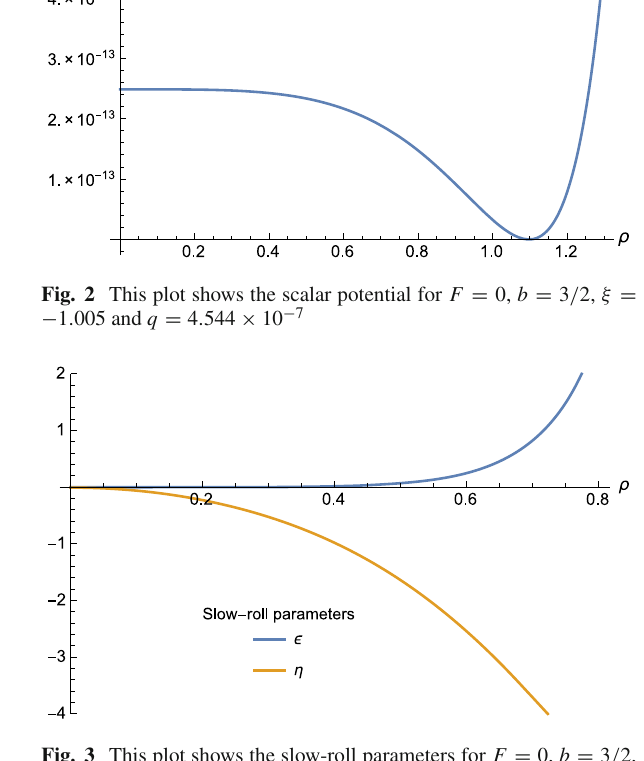
Fig. 3 This plot shows the slow-roll parameters for F = 0, b = 3 / 2, ξ = − 1 . 005 and q = 4 . 544 × 10 −